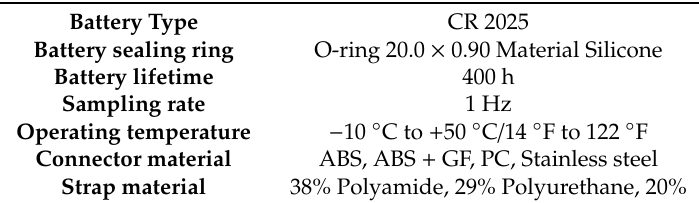
Table 1. Polar H10 specifications. Data from